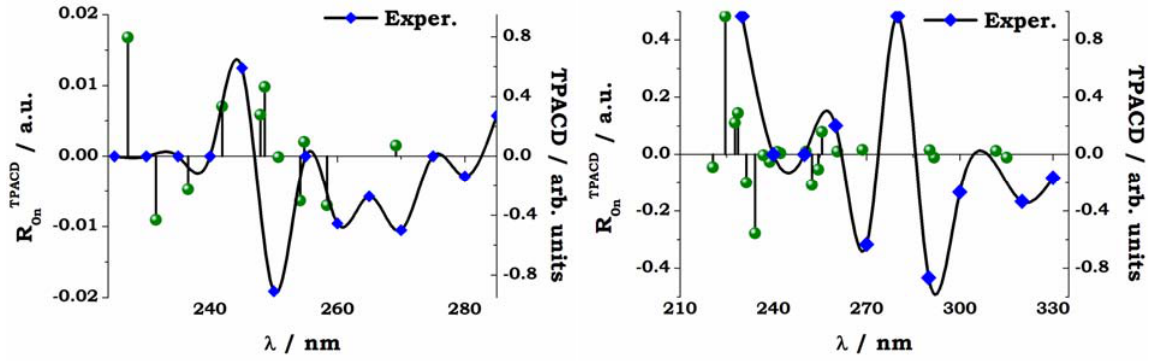
Figure 12. S -VANOL (left panel) and S -VAPOL (right panel). Comparison of experiment and theory for the TPCD spectra. The vertical sticks are the ab initio TPCD rotatory TPACD R ), computed for the lowest twenty excited electronic states. The computed strengths ( 0 n excitation energies are red shifted by 20 nm in S-VANOL, by 10 nm in S -VAPOL. These values were chosen to bring the maximum of OPA peaks as close as possible to the experimental peak located around 250 nm ( S -VANOL) and 290 nm ( S -VAPOL). See Ref.